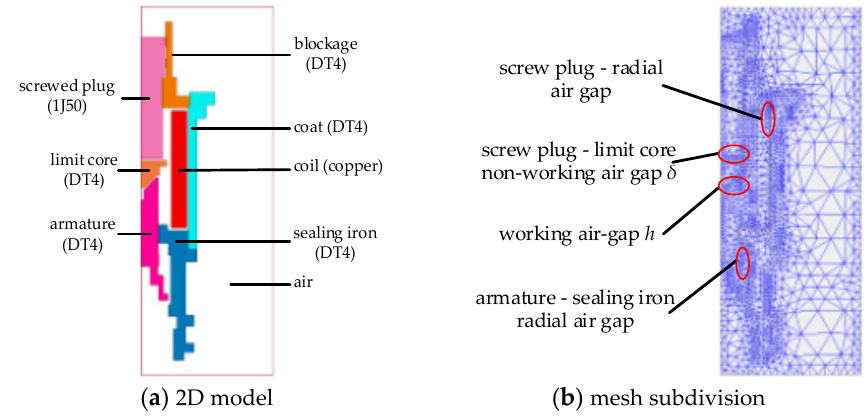
Figure 5. Static magnetic field model and meshing of valve.